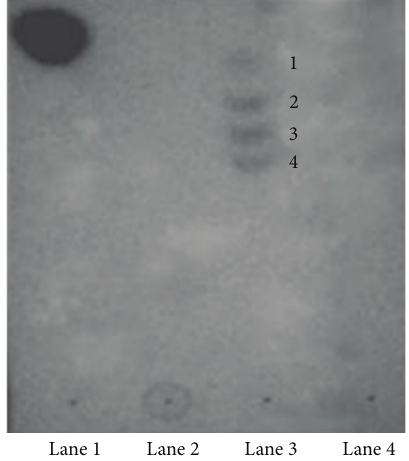
Figure 8: Demonstration of endoxylanolytic nature of crude xylanase preparation of strain X1. Lane 1 indicates standard D- xylose. Lanes 2 and 3 represent the methanol extract of control and treated xylan, while Lane 4 represents crude xylanase, respectively. Numbers (1–4) represent compounds present in crude xylanase- treated